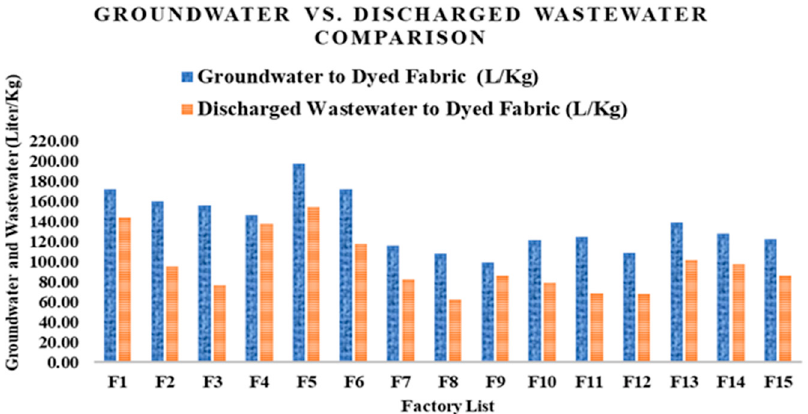
Figure 6. Groundwater vs. effluent discharged wastewater comparison based on dyed fabric amount (kg).